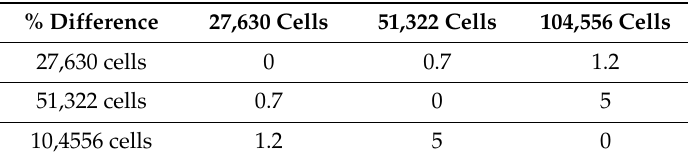
Table 2. Independence mesh test.